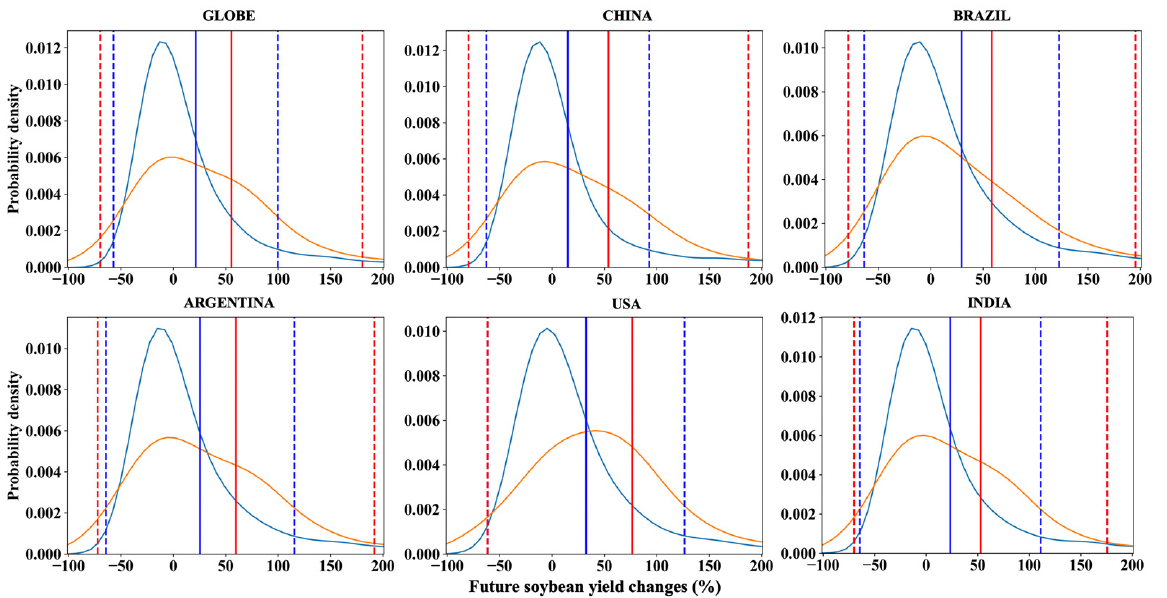
Figure 10. Probability distribution of future (2040–2099) soybean yield uncertainties compared with mean yield of baseline (1981–2005) for the globe and main producing countries. The blue and orange line are the probability distribution of the simulated soybean yield from the GEPIC and hybrid models, respectively. The vertical solid and dash lines indicate the mean and ± standard deviation of future soybean yield changes.